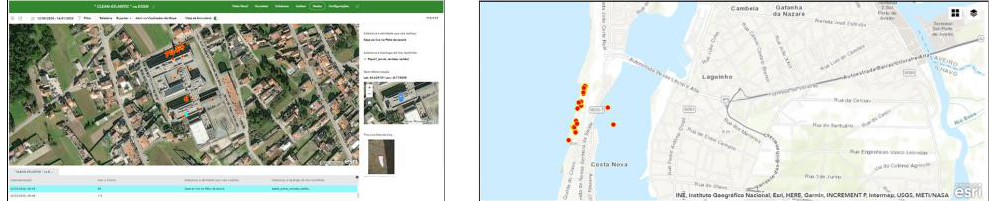
Figure 17. Survey123 map with a detailed view of collected data. Red dots correspond to the GPS location of each collected waste.